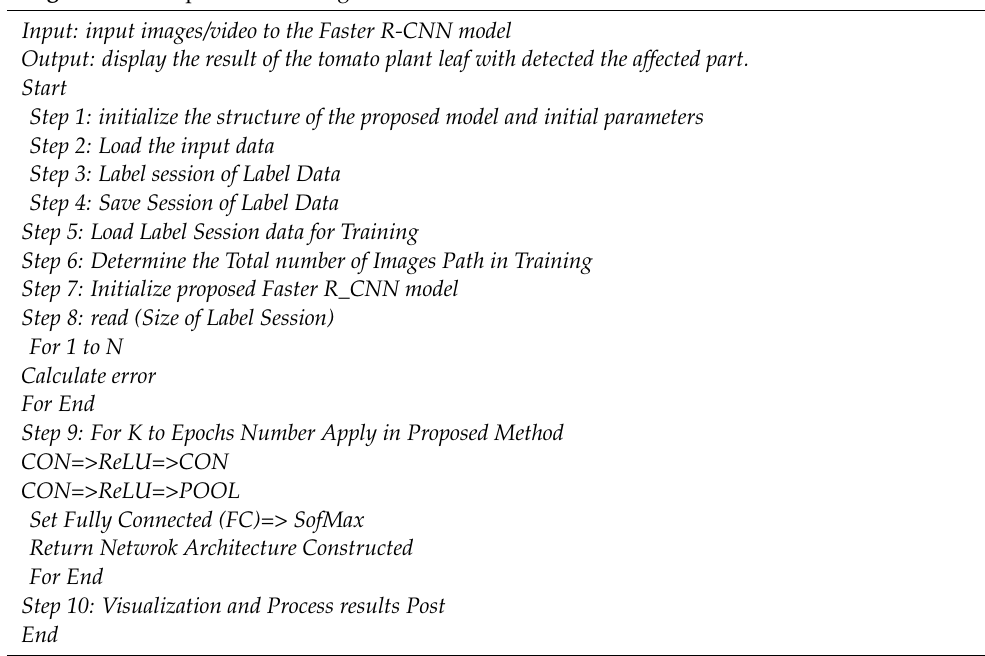
Algorithm 1 Proposed model algorithm